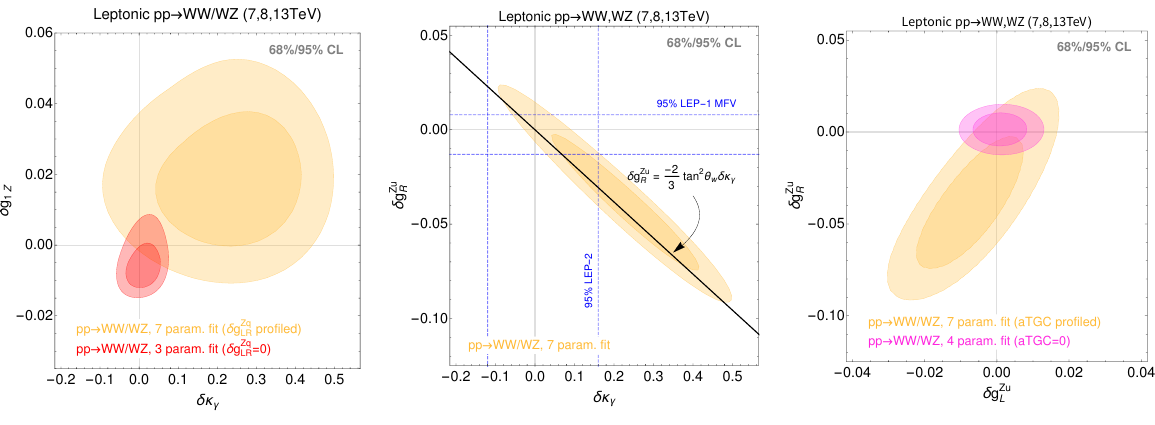
Figure 2 . 68% (dark shaded) and 95% (light shaded) CL regions using the LHC diboson data reported in table 1. Center: (cid:12)t to (cid:14)(cid:20) (cid:13) and (cid:14)g Zu pro(cid:12)ling over all other (cid:12)ve parameters. The line R shows the expected (cid:13)at direction in the ^ s ! 1 limit that can be deduced from eq. (2.6). Left (Right): in yellow the (cid:12)t to aTGC (vertex corrections) marginalising over all other parameters, and in red (pink) the (cid:12)t when the four (cid:14)V (cid:22) qq (three aTGC) are set to zero. The least constrained direction in this plot follows the slope given by the combination